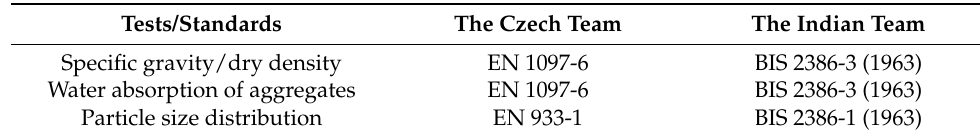
Table 2. The overview of test methods for aggregates.